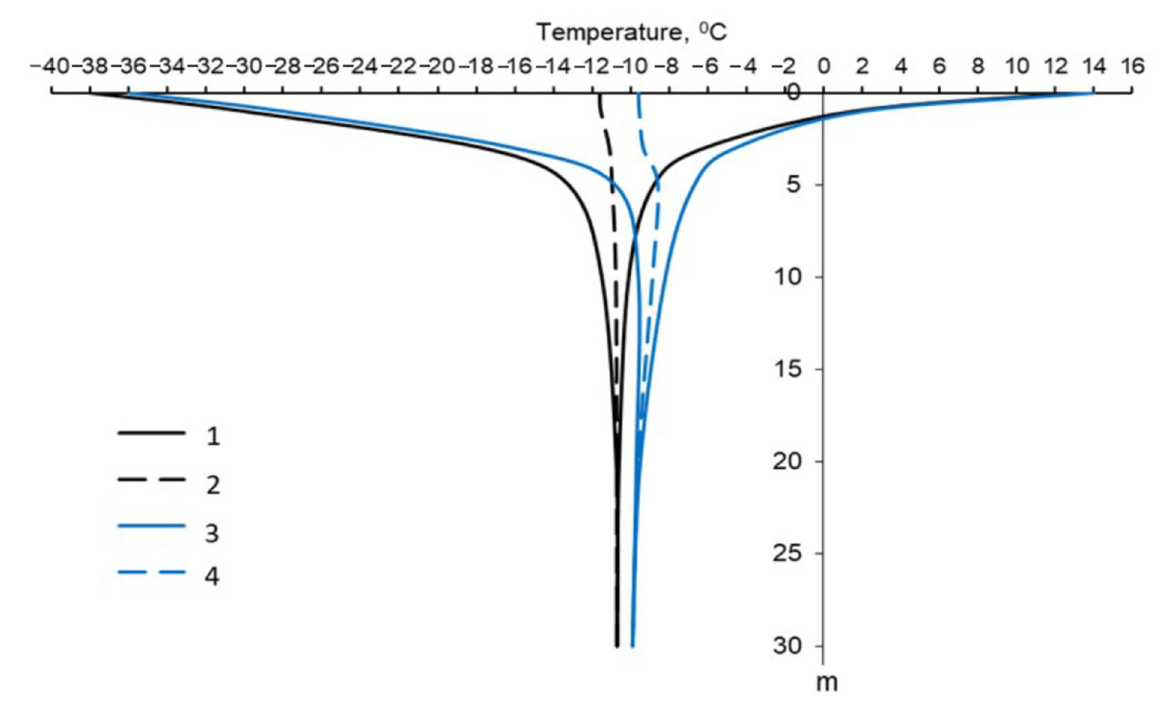
Figure 6. Temperature profiles from the 30-m borehole in the stone ridge (Site 1) for 1992–1993 and 2021–2022. 1—minimal and maximum temperatures in 1992–1993; 2—mean annual temperatures in 1992–1993; 3—minimal and maximal temperatures in 2021–2022; 4—mean annual temperatures in 2021–2022.